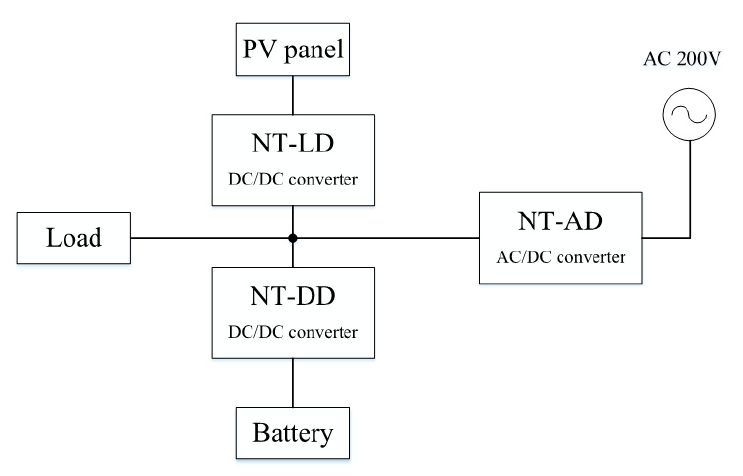
Figure 16. DC distribution system used for testing the developed circuit.